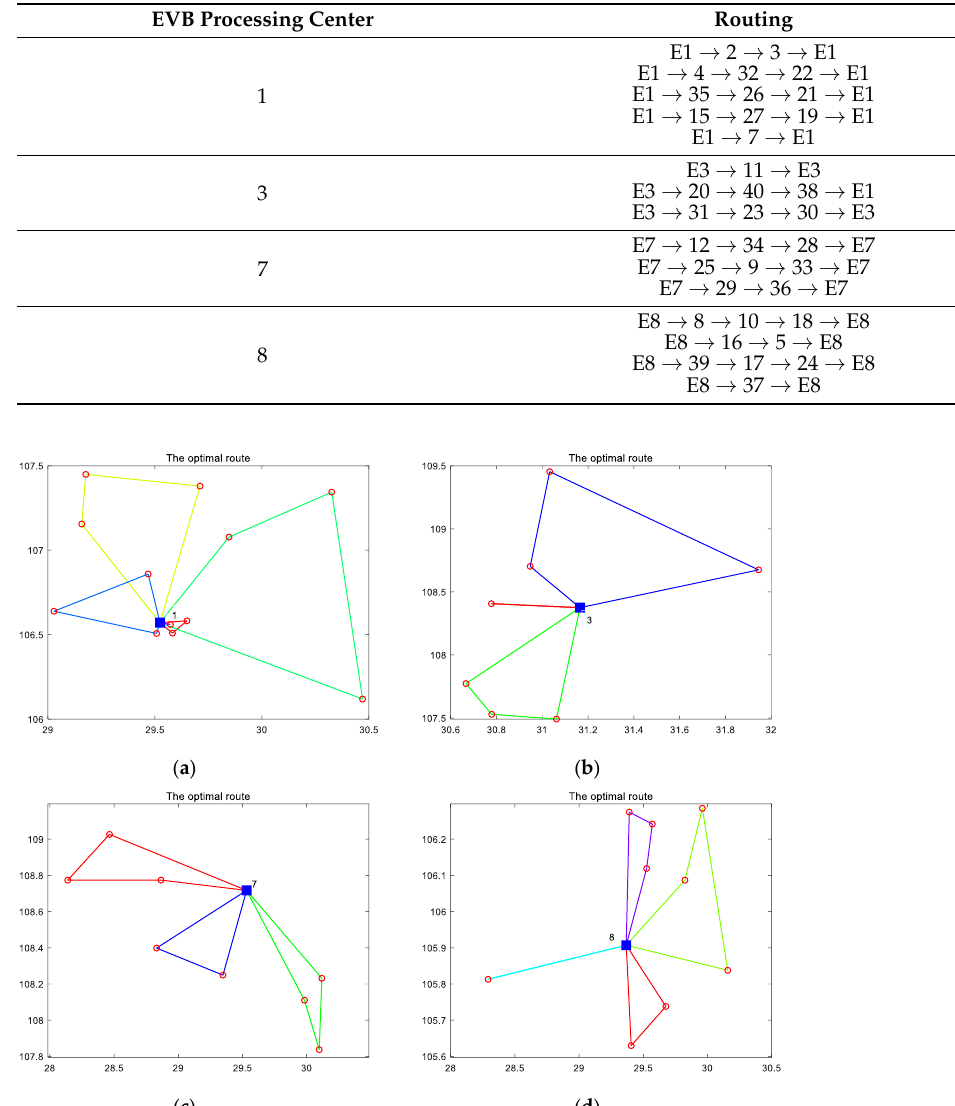
Table 9. Optimal scheme for vehicle path planning.